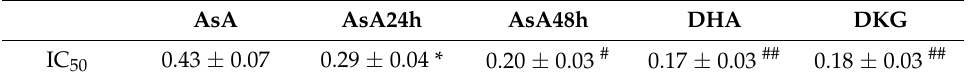
Figure 3. ThT assay to monitor the kinetics of insulin fibrillation in the presence of DHA ( A ) and DKG ( B ). Filled triangles, insulin only; filled squares to open squares, insulin incubated with an inhibitor at a concentration of 0.2, 0.4, 0.6, and 0.8 mM, respectively. Table 1. IC 50 values (mM) of substances exhibiting inhibition of insulin fibrillation.